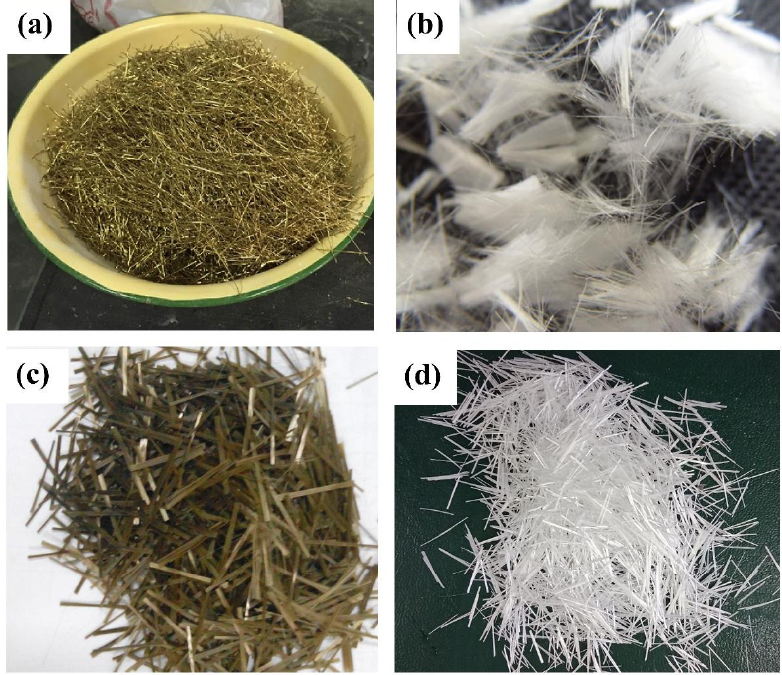
Figure 9. Commonly used reinforcing fibers in recycled aggregate concrete. ( a ) SF, ( b ) PP, ( c ) BF, and ( d ) GF. Copyright permission is obtained from ( a ) [128], ( b ) [129], ( c ) [130], ( d ) [96]. Table 3. Physical properties of SF, GF, BF, and PP